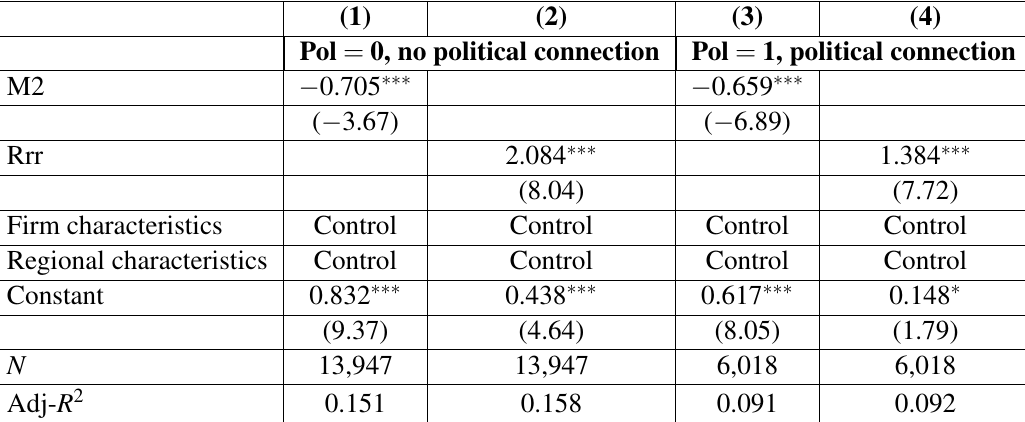
Table 7 Monetary policy and stock pledge with different political